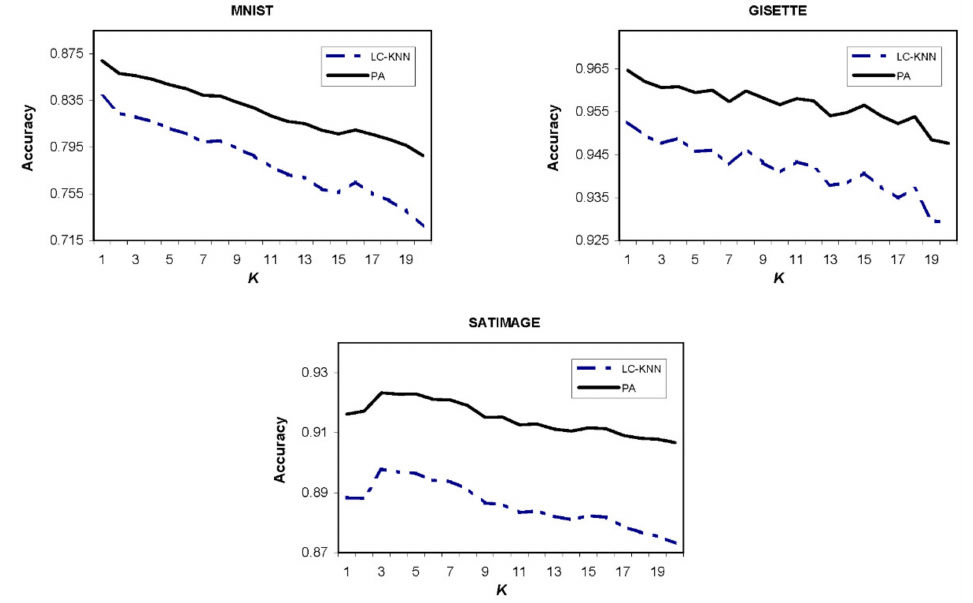
Figure 5. Classification accuracy of the proposed approach (PA) and LC-KNN for di ff erent k values. As it can be seen, the higher values of the k parameter lead to the lower classification accuracy, in general, for both the proposed approach and